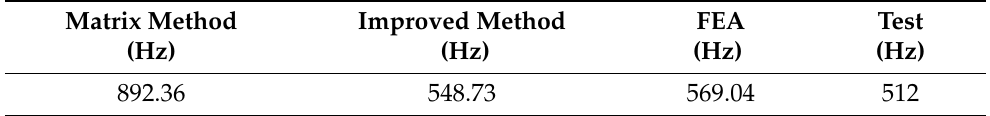
Table 2. Comparison of the natural